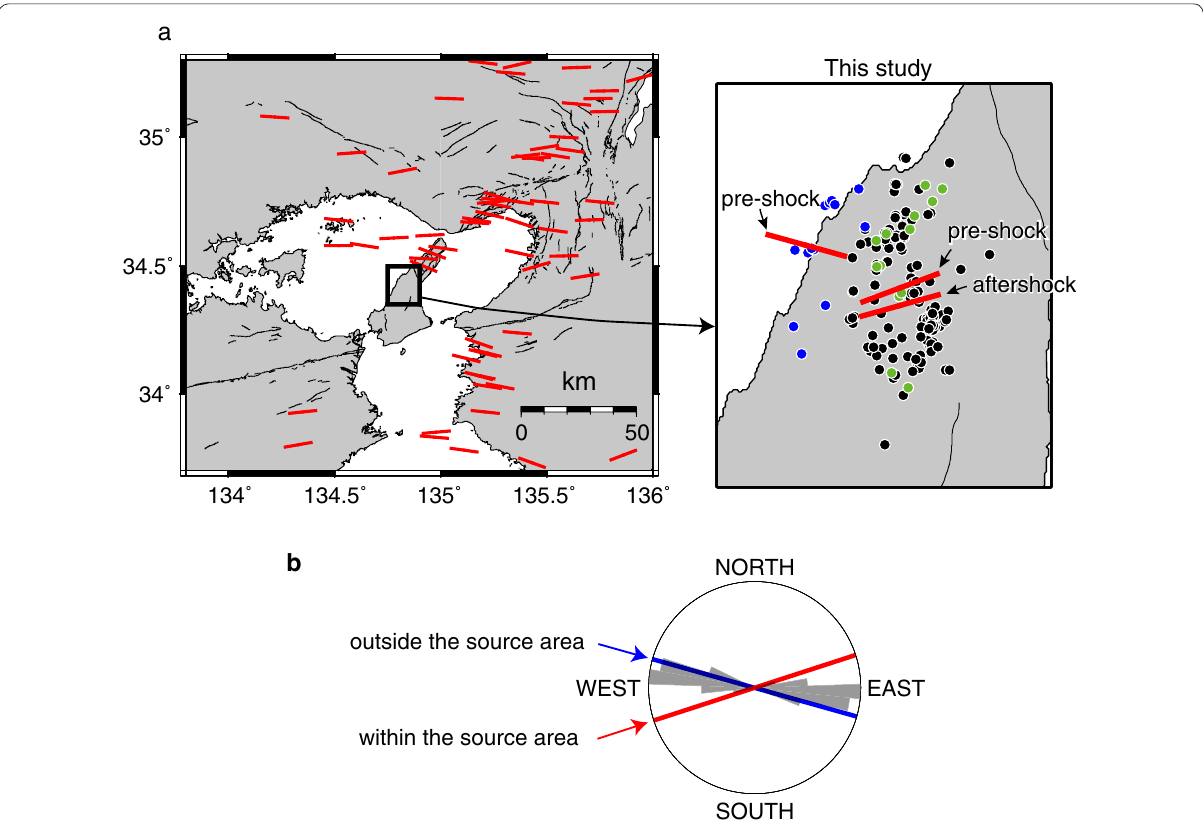
Fig. 12 Maximum horizontal compressive stress ( S Hmax ) in and around the Awaji Island. a Map showing the axes of maximum horizontal compressive stress ( S Hmax ) determined in the present study (right) together with that reported by Townend and Zoback (2006) and Matsushita and Imanishi (2015). Circles in the right map correspond to earthquakes used in the stress tensor inversion (see Fig. 8). b Rose diagram of S Hmax orientation shown in a . The red and blue lines indicate S Hmax orientation within and outside the source area determined in the present study, respectively. Regarding the orientation within the source area, the average value is